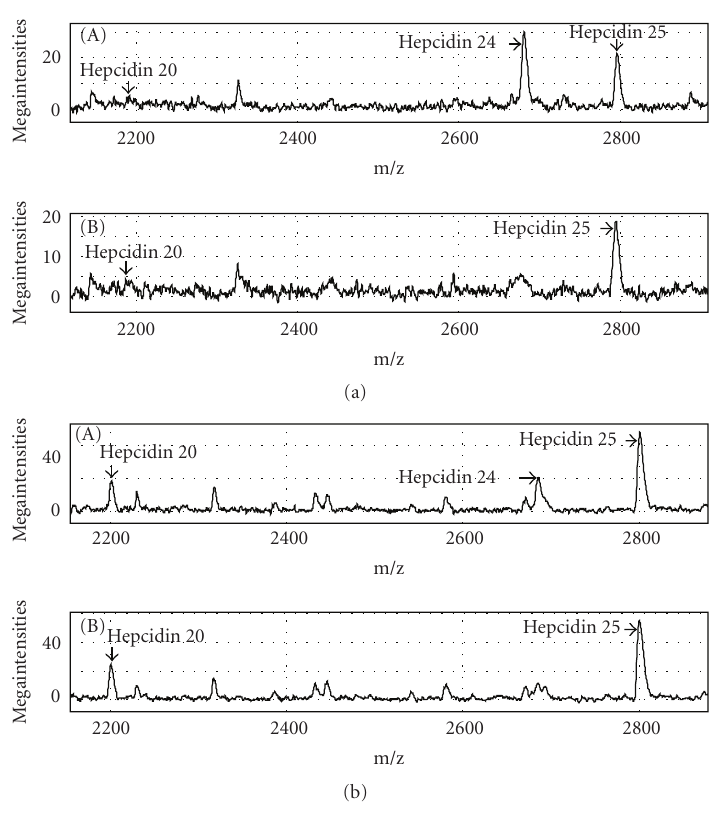
Figure 1: SELDI-TOF MS profile of hepcidin-24-spiked serum samples of hemodialysis patient (a) and control (b). The hepcidin isoforms hepcidin-20, hepcidin-24 (synthetic analogue, panel (B)), and hepcidin-25 are indicated by arrows.